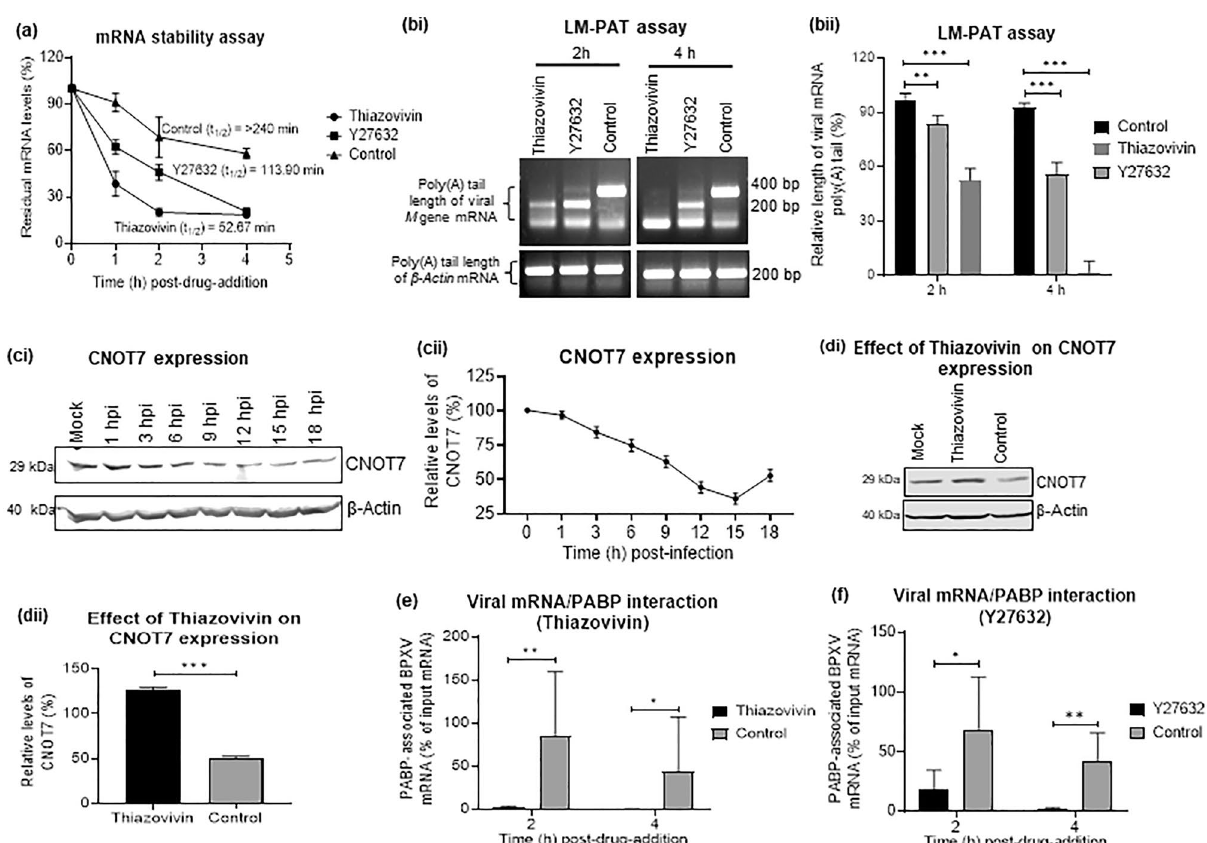
Figure 3. Thiazovivin induces viral mRNA decay. ( a ) Measurement of mRNA stability: Vero cells, in triplicates, were infected with BPXV at MOI of 5. At 9 hpi, cells were treated with Thiazovivin (1 µg/ml), Y27632 (1.5 µg/ ml) or equivalent volumes of DMSO in the presence of Actinomycin D (5 µg/ml). Cells were subjected to RNA isolation at indicated time points (post-drug treatment) and subjected to cDNA synthesis and quantified for BPXV M gene by qRT–PCR. The relative levels of viral mRNA at 0 h, 1 h, 2 h and 4 h in Thiazovivin or Y27632- and control-treated cells are shown. n = 3 independent experiments. ( b ) LM-PAT assay. Vero cells were infected with BPXV. At 9 hpi, the cells were treated with the inhibitors (Thiazovivin or Y27632) or DMSO in the presence of Actinomycin D. At indicated times post-drug-addition, cells were scrapped to isolate the RNA. The RNA was allowed to react with an adaptor oligo(dT) primer in the presence of T4 DNA ligase and subjected to cDNA synthesis. The length of poly(A) tail of viral ( M ) and cellular (β-actin) mRNA were determined by PCR by using an anchor primer and a gene-specific primer (bi). The length of the PCR product (BPXV M gene) in inhibitor- treated and control-treated cells was measured (ImageJ) and the relative length of the viral mRNA poly(A) tail (% of control) at different times treatment was calculated (bii). Data are presented as mean with SD. n = 3 independent experiments. See Supplementary Fig. 6b for full gel. ( c ) Kinetics of CNOT7 expression. Vero cells were either mock-infected or infected with BPXV at MOI of 5. Cell lysate were prepared at indicated time points and subjected for detection of CNOT7 levels in Western blot analysis. The levels of CNOT7 (upper panel) and β-actin (house-keeping control protein, lower panel) are shown (ci). The line graph (cii) shows the band intensity of the protein at different times post-infection. The blots were quantified by densitometry (ImageJ) and the data are presented as mean with SD. n = 3 independent experiments. See Supplementary Fig. 6b for full blots. ( d ) Effect of Thiazovivin on CNOT7 expression. Vero cells were either mock-infected or infected with BPXV at MOI of 5. Thiazovivin or vehicle controls were added at 6 hpi. Cell lysates were prepared at 9 hpi and subjected for detection of CNOT7 levels in Western blot analysis (di). The histogram (dii) shows the band intensity of the protein. The blots were quantified by densitometry (ImageJ) and the data are presented as mean with SD. n = 3 independent experiments. See Supplementary Fig. 6c for full blots. (e and f) ROCK1 inhibition blocks interaction of BPXV mRNA with PABP (CHIP assay).Vero cells, in triplicates, were infected with BPXV at MOI of 5. At 9 hpi, the cells were treated with ROCK1 inhibitors (Thiazovivin and Y27632) or vehicle control. At 2 h and 4 h post-drug addition, the cell lysates were prepared as per the procedure described for CHIP assay (materials and method section). The clarified cell lysates were incubated with α-PABP or equivalent volume of the IP buffer (Beads control), followed by incubation with Protein A Sepharose® slurry. The beads were then washed five times in the IP buffer. To reverse the cross-linking, the complexes were then incubated with Proteinase K. Finally, the reaction mixtures were centrifuged and the supernatant was subjected to cDNA preparation and quantitation of BPXV RNA (M gene) by qRT-PCR. The percentage of the input BPXV mRNA bound to PABP in Thiazovivin-treated ( e ) and Y27632-treated cells ( f ) is shown. n = 3 independent experiments. Error bars indicate SD. Pair-wise statistical comparisons were performed using Student’s t-test (***P < 0.001; **P < 0.01; *P <